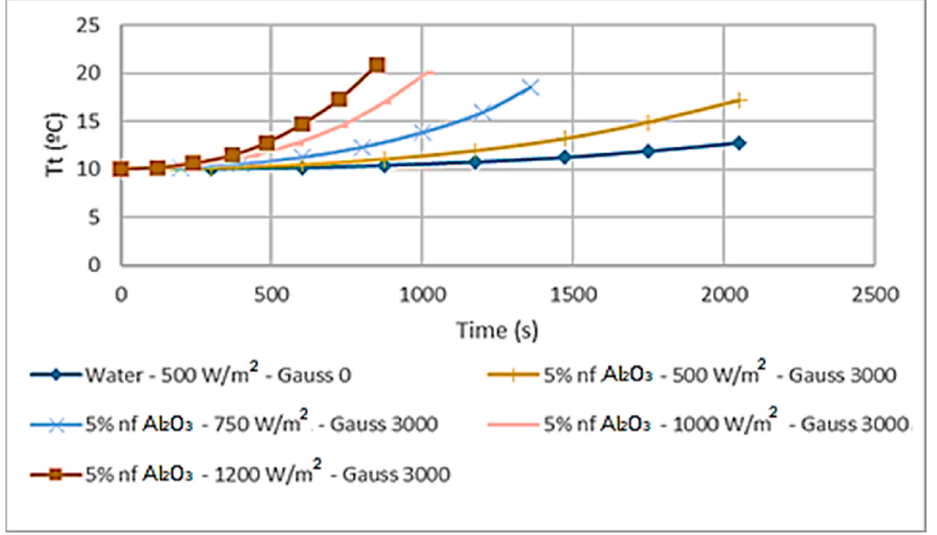
Figure 20. Thermal storage tank dynamic temperature profile generated by PV-Th solar panels with different solar radiations.